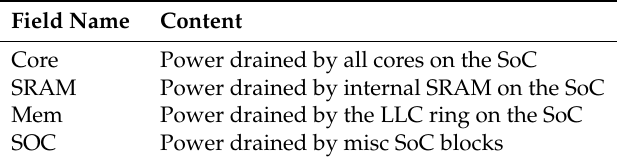
Table 2. The tx2mon application requires root privileges and the tx2mon_kmod kernel module loaded. Table 2. Power related fields readable on the